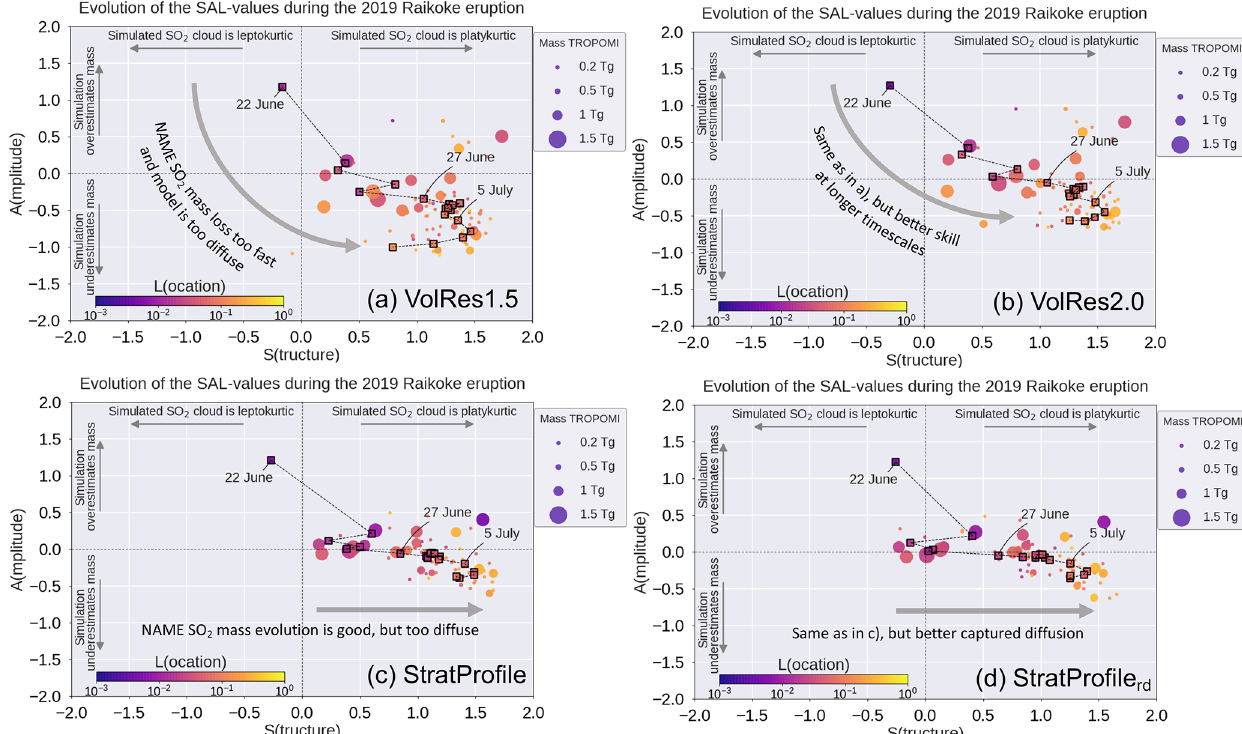
Figure 10. Time evolution of the SAL values for four different NAME simulations: (a) VolRes1.5, (b) VolRes2.0, (c) StratProfile and (d) StratProfile rd . The black dashed line shows the daily average evolution of the S and A parameters between 22 June and 10 July, while the coloured squares show the daily average values of L . The coloured dots represent the SAL values for each individual TROPOMI overpass as shown in Fig. 2. To obtain the A parameter, we have excluded the SO 2 VCDs of TROPOMI below 0.3DU to reduce noise but included all mass for the NAME simulations (see Sect.